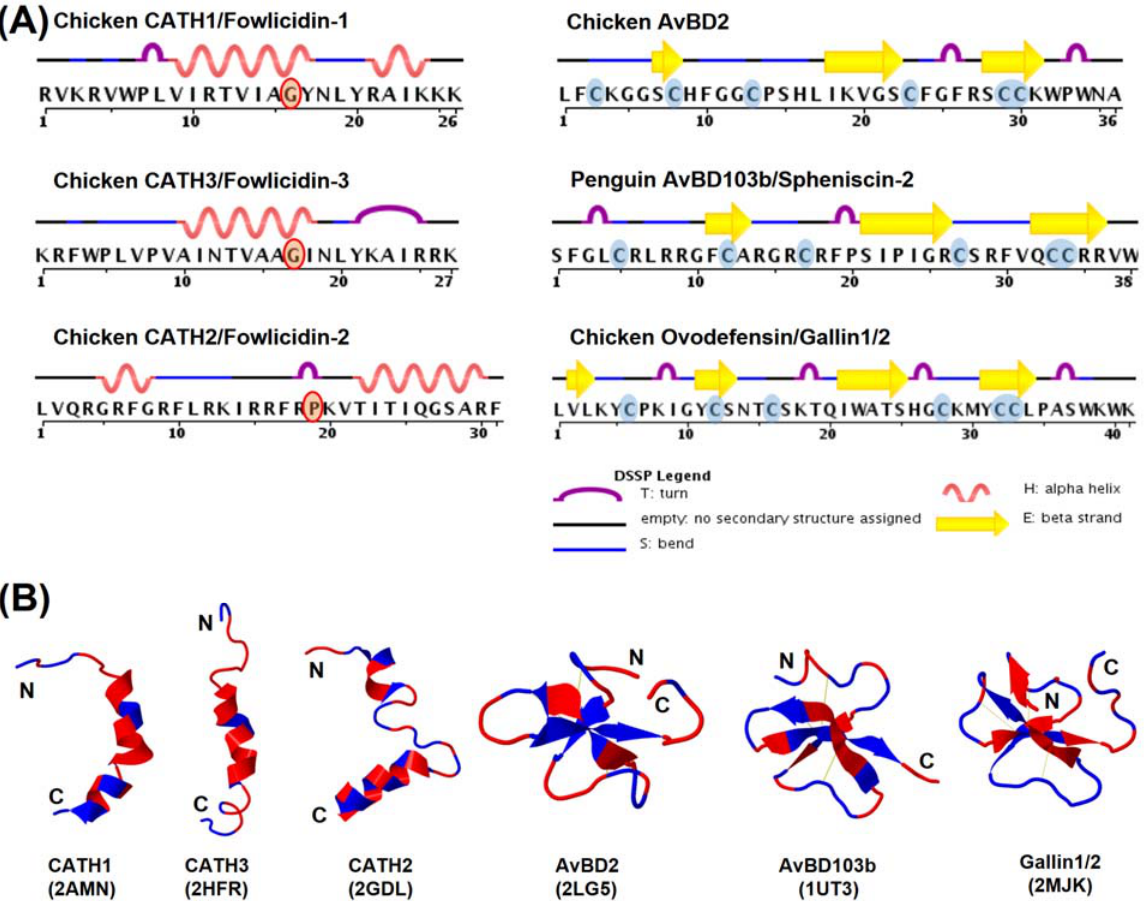
Figure 6. Structures of avian cathelicidins and β -defensins. ( A ) Secondary structural features of cathelicidins and β -defensins. ( B ) Tertiary ribbon structures of cathelicidins and β -defensins. Polar residues are indicated in blue and nonpolar residues in red. Disulfide bonds of β -defensins are shown in yellow. Protein Data Bank identification number for each molecule is indicated in